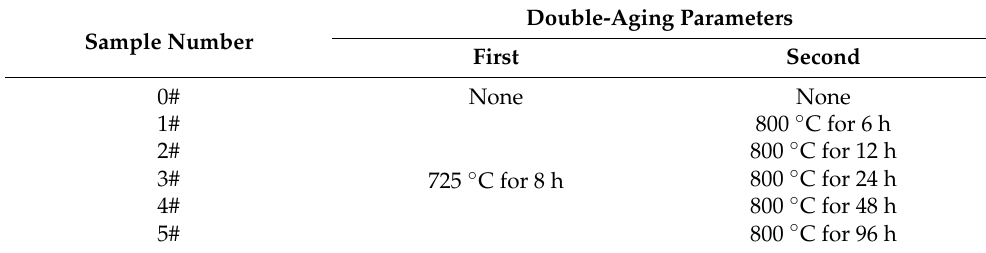
Figure 1. Schematic diagram of the double-aging treatment on the 945A Ni-based alloy. Table 2. Parameters of the double-aging treatment on the 945A Ni-based alloy. Table 2. Parameters of the double-aging treatment on the 945A Ni-based alloy.